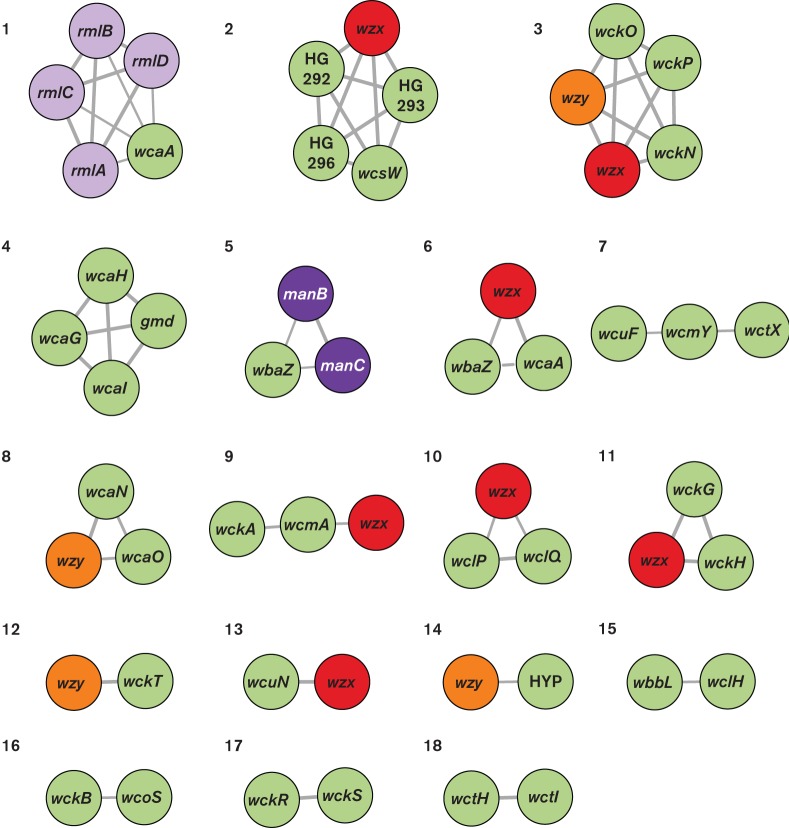
Co-occurrence of wzx, wzy and sugar processing genes across reference K-loci. Nodes represent genes, labelled by name and coloured by protein product as in Figs 2 and 3: Wzx (red), Wzy (orange), mannose synthesis/processing proteins (dark purple), rhamnose synthesis/processing proteins (light purple), other proteins (green). Edge widths are proportional to Jaccard index (J) and are shown for all pairs where J≥0.61. Numbers represent co-occurrence group assignments as defined in Table S5. HYP, Hypothetical protein.